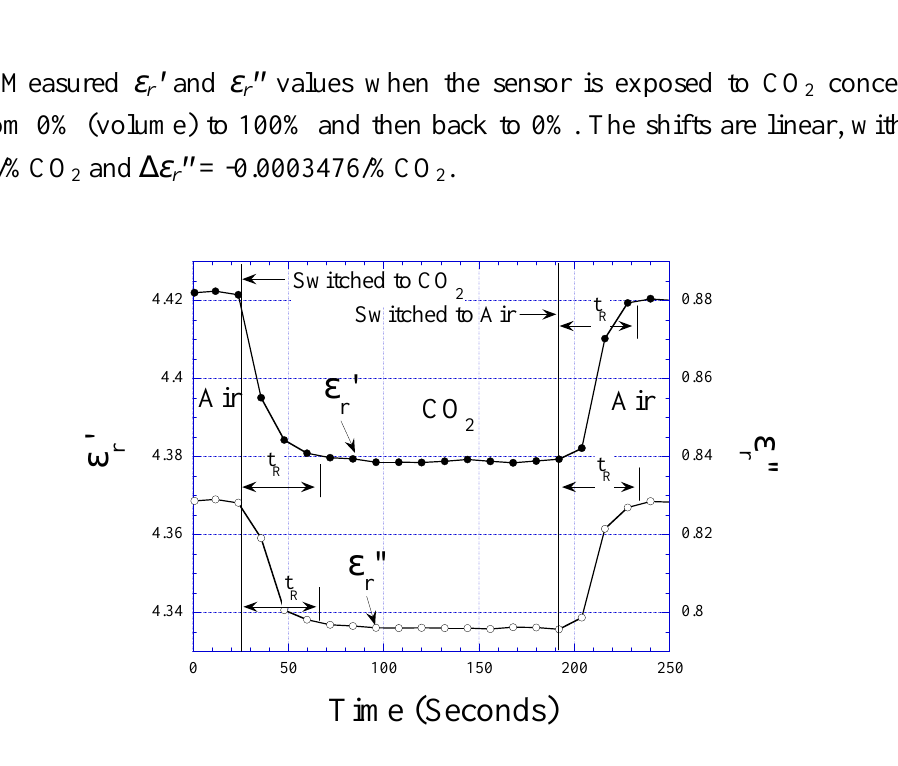
, and then back to air. 2